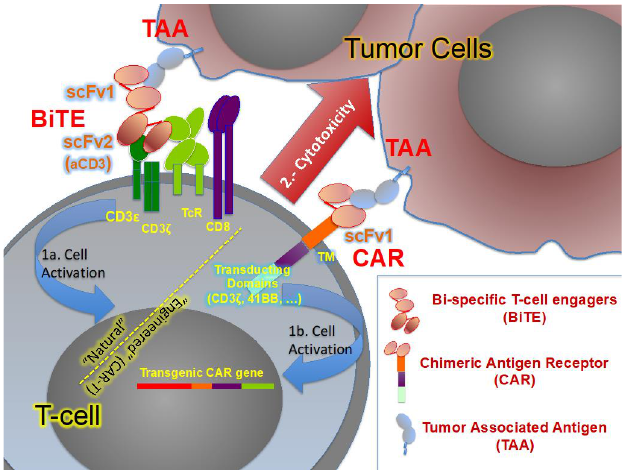
Figure 2. Comparison between the mechanisms of BiTE and CAR in T cells to activate (1) these lymphocytes after the recognition of the corresponding tumor associated antigen TAA. After activation, these T cells exert an antitumoral effect (2), mainly through cytotoxicity. Table 3. Ongoing clinical trials with BITE therapy in metastatic castration-resistant prostate cancer. HLE: half-life extended; PSMA: prostate-specific membrane antigen; STEAP1: six transmembrane epithelial antigen of the prostate 1. NCT Number. Title BiTE Location (n. of Centers) Sponsors